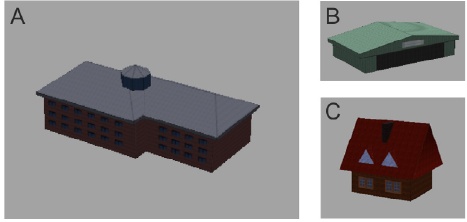
Fig. 12. Visualization of prepared 3D models: